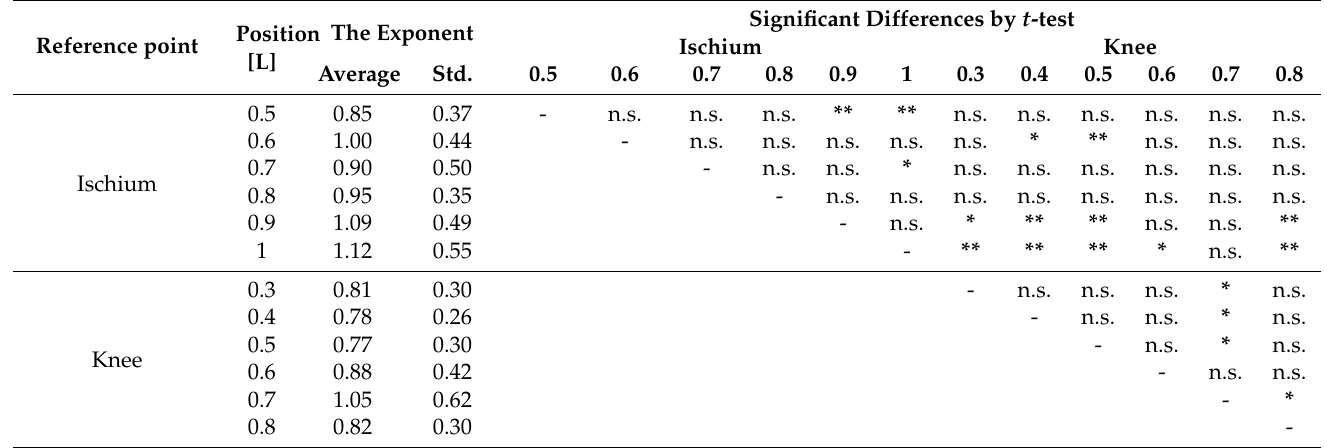
Table 1. The significant differences between the measured